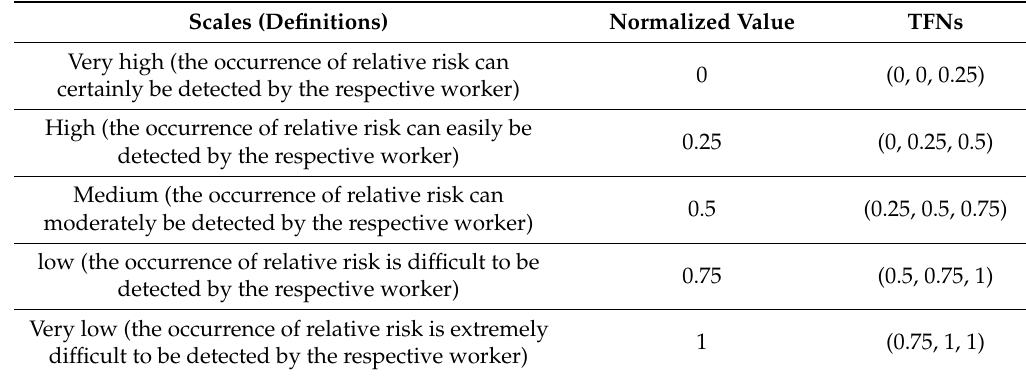
Table 5. Linguistic variables for